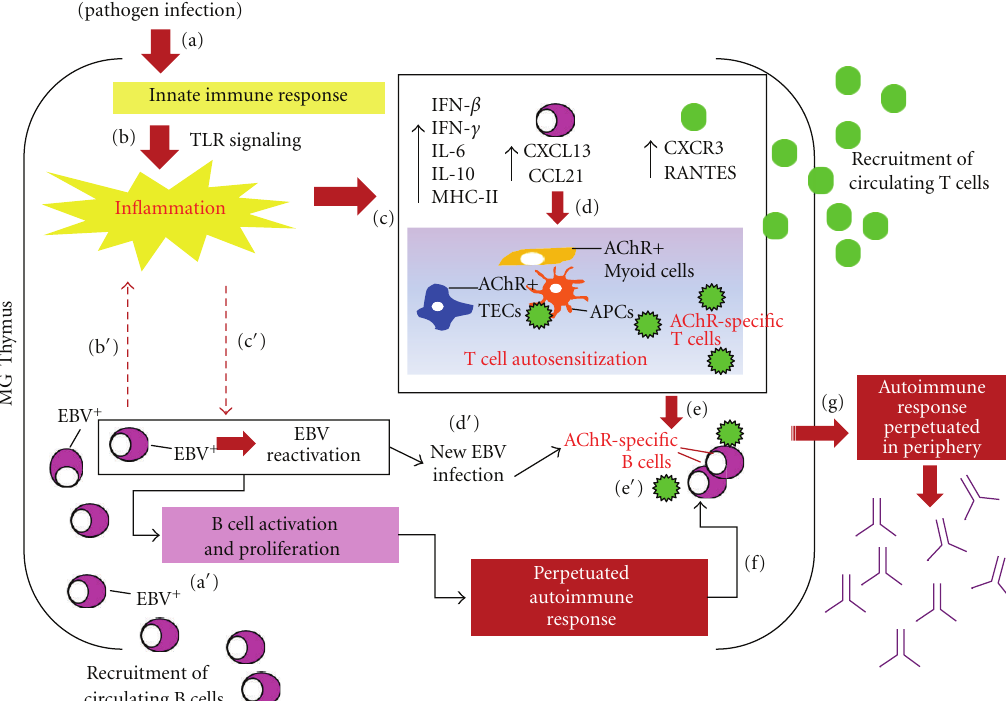
Figure 7: Proposed model of virus-induced autoimmunity in MG. A “danger signal” (e.g., pathogen infection) stimulates Toll-like receptor- (TLR-) mediated innate immune responses (a), whose dysregulated or persistent activation leads to the chronic inflammation characteristic of MG thymus (b). The chronically established thymic inflammatory state (c), characterized by overexpression of proinflammatory cytokines (e.g., IL-6, IL-10), type I and II IFNs, and T- and B-lymphocyte-attracting chemokines (e.g., CXCR3, RANTES, CXCL13, CCL21), is essential, in the context of a genetically predisposing background, for the establishment of mechanisms (d) contributing to T-cell autosensitization, including presentation or cross-presentation of “self-epitopes” by TECs or myoid cells expressing the autoantigen; upregulation of MHC genes; activation of antigen-presenting cells (APCs); as well as the constant priming of autoreactive T cells, which in turn promote autoimmune response by autoreactive B cells (e). B cell attractants CXCL13 and CCL21 recruit circulating B cells to thymus, including those harboring EBV (a (cid:3) ). EBV infection itself contributes to thymic inflammation (b (cid:3) ). EBV reactivation, influenced by the inflammatory state (c (cid:3) ), results in EBV propagation to uninfected B cells (d (cid:3) ) including AChR-specific B cells (e (cid:3) ). The chronically established inflammation and EBV infection promote the maintenance within the thymus of the autoimmune response (f), which may be thus perpetuated in periphery